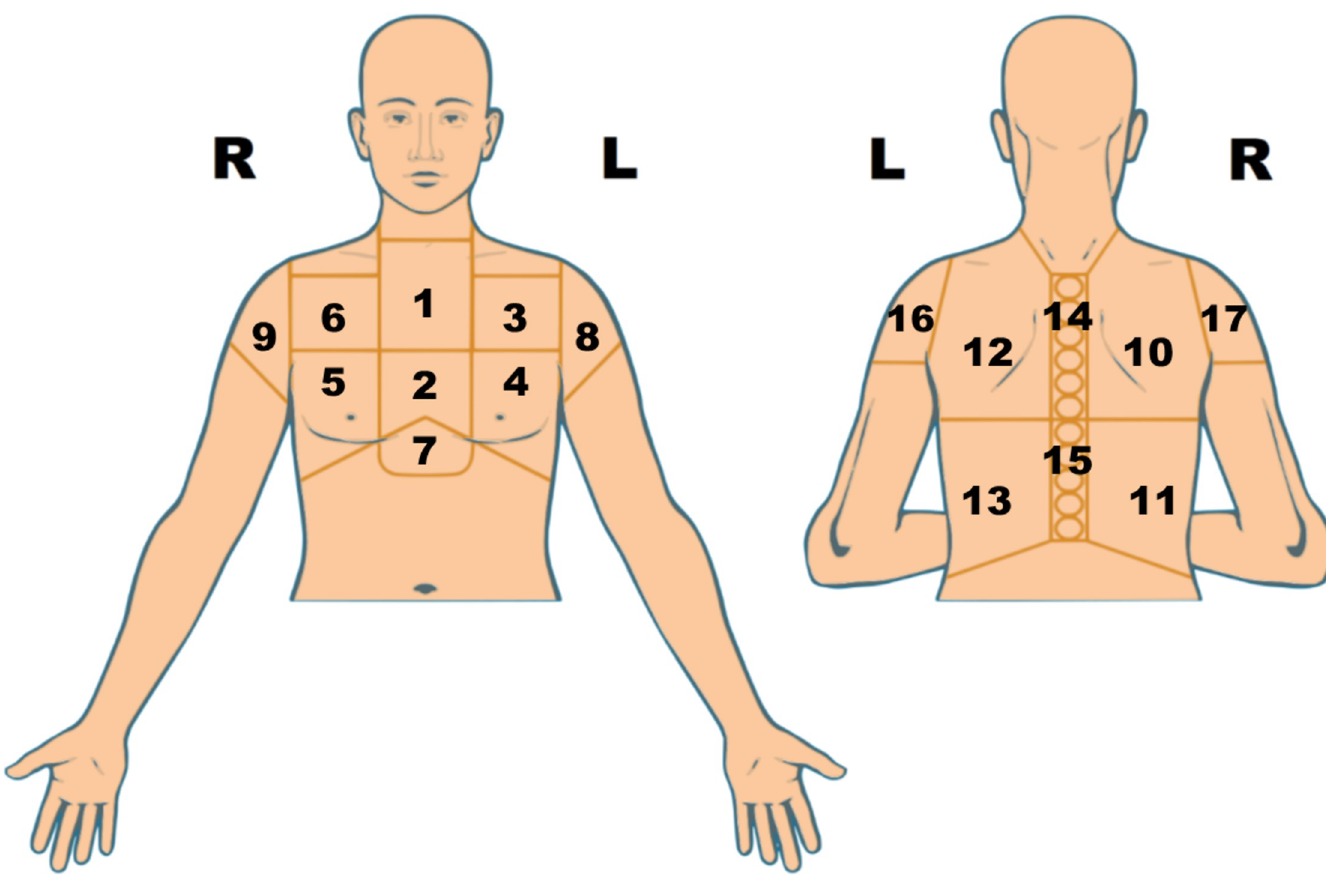
Fig 2. Image used by patients to enter sites of chest pain. Tapping on any region of the image added blue color to it. The patient could deselect a blue area with a second tap. The areas in the image presented to patients were not numbered. We show numbers here because they indicate the areas of pain in S1 Fig.